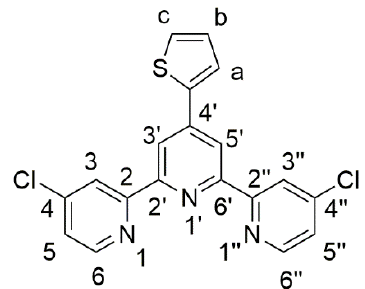
Figure 1. Structure and atom numbering of 4,4 ′′ -dichloro-4 ′ -(2-thienyl)-2,2 ′ :6 ′ ,2 ′′ -terpyridine ( 1 ).